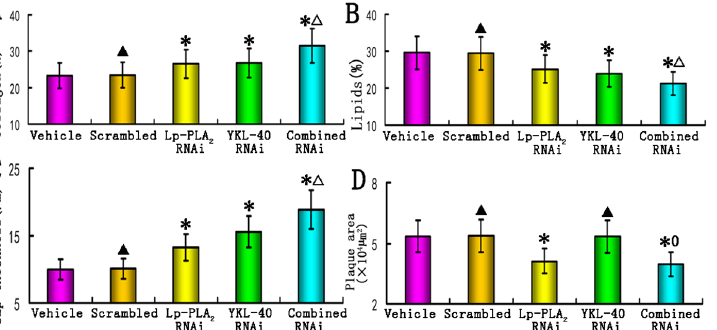
Fig 4. Comparison of plaque morphology. (A) Comparison of relative collagen content in the plaques of the vehicle, scrambled, Lp-PLA 2 RNAi, YKL-40 RNAi, and combined Lp-PLA 2 and YKL-40 RNAi groups (n = 12); (B) Comparison of relative lipid content in the plaques from all groups (n = 12). (C) Comparison of fibrous cap thickness in the plaques of all groups (n = 12). (D) Comparison of plaque area in the plaques of all groups (n = 12). (cid:3) P < 0.05 vs. vehicle groups; ▲ P > 0.05 vs. vehicle group; 4 P < 0.05 vs. Lp-PLA 2 RNAi and YKL-40 RNAi groups. 0 P > 0.05 vs. Lp- PLA 2 RNAi